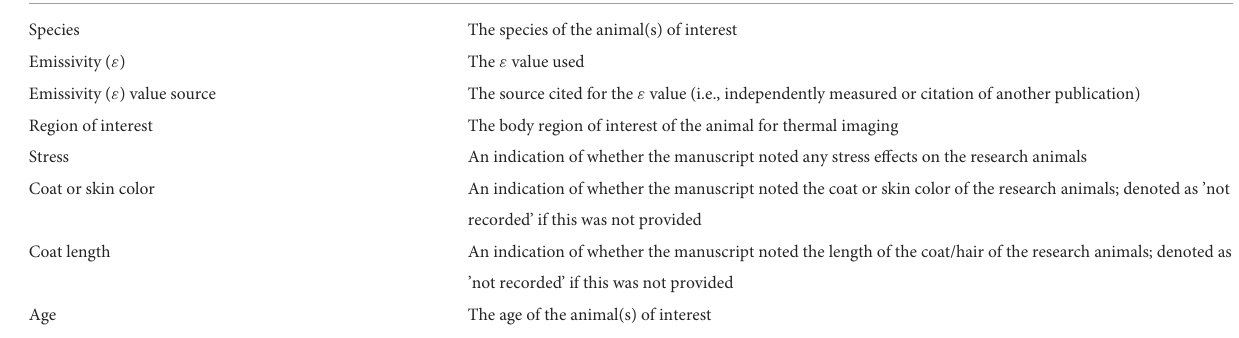
TABLE 4 Animal-related